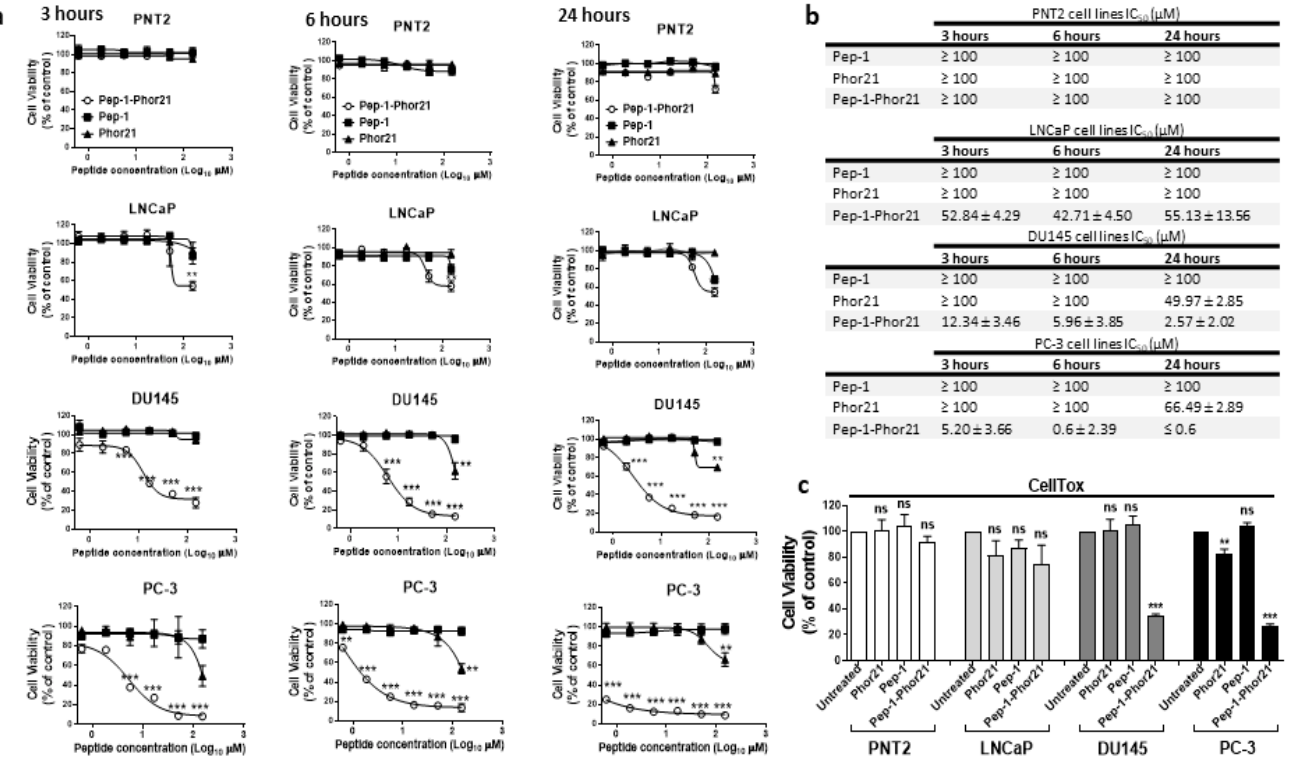
Figure 3. The cytotoxic effect of Pep-1-Phor21 peptide on prostate cancer cells. ( a ) Dose-dependent effect of Pep-1-Phor21 ( ○ ), Pep-1 ( ■ ) and Phor21 ( ▲ ) on the viability of non-IL-13R α 2-expressing cell lines (PNT2 and LNCaP) and IL-13R α 2-expressing cell lines (DU145 and PC-3). The viability of cells treated with 0–150 µ M of either Pep-1-Phor21, Phor21 or Pep-1 peptide for 3 h, 6 h or 24 h was assessed using alamarBlue assay. ( b ) The IC 50 of peptides for various cell lines for different incubation times. ( c ) The effect of Pep-1-Phor21, Pep-1 and Phor21 on the viability of non-IL-13R α 2-expressing and IL-13R α 2-expressing cell lines was assessed using CellTox assay. PNT2 (120 µ M), LNCaP (120 µ M), DU145 (24 µ M) and PC-3 (10 µ M) cells were incubated with Pep-1-Phor21, Phor21 or Pep-1 peptide (the concentration used for each cell line is shown next to it in the brackets) for 3 h before their viability was assessed using CellTox assay. The data represent means ± SEM (error bars represent SEM) of three independent experiments (** p < 0.01; *** p < 0.001; ns, not